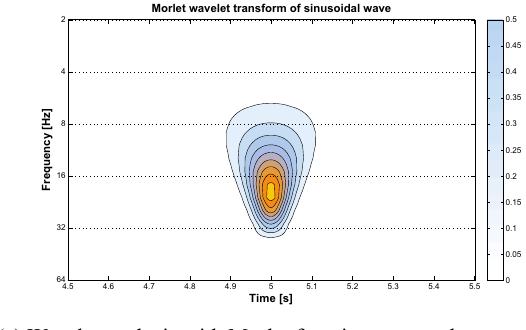
Table 2: Wavelet mother function Mexican hat